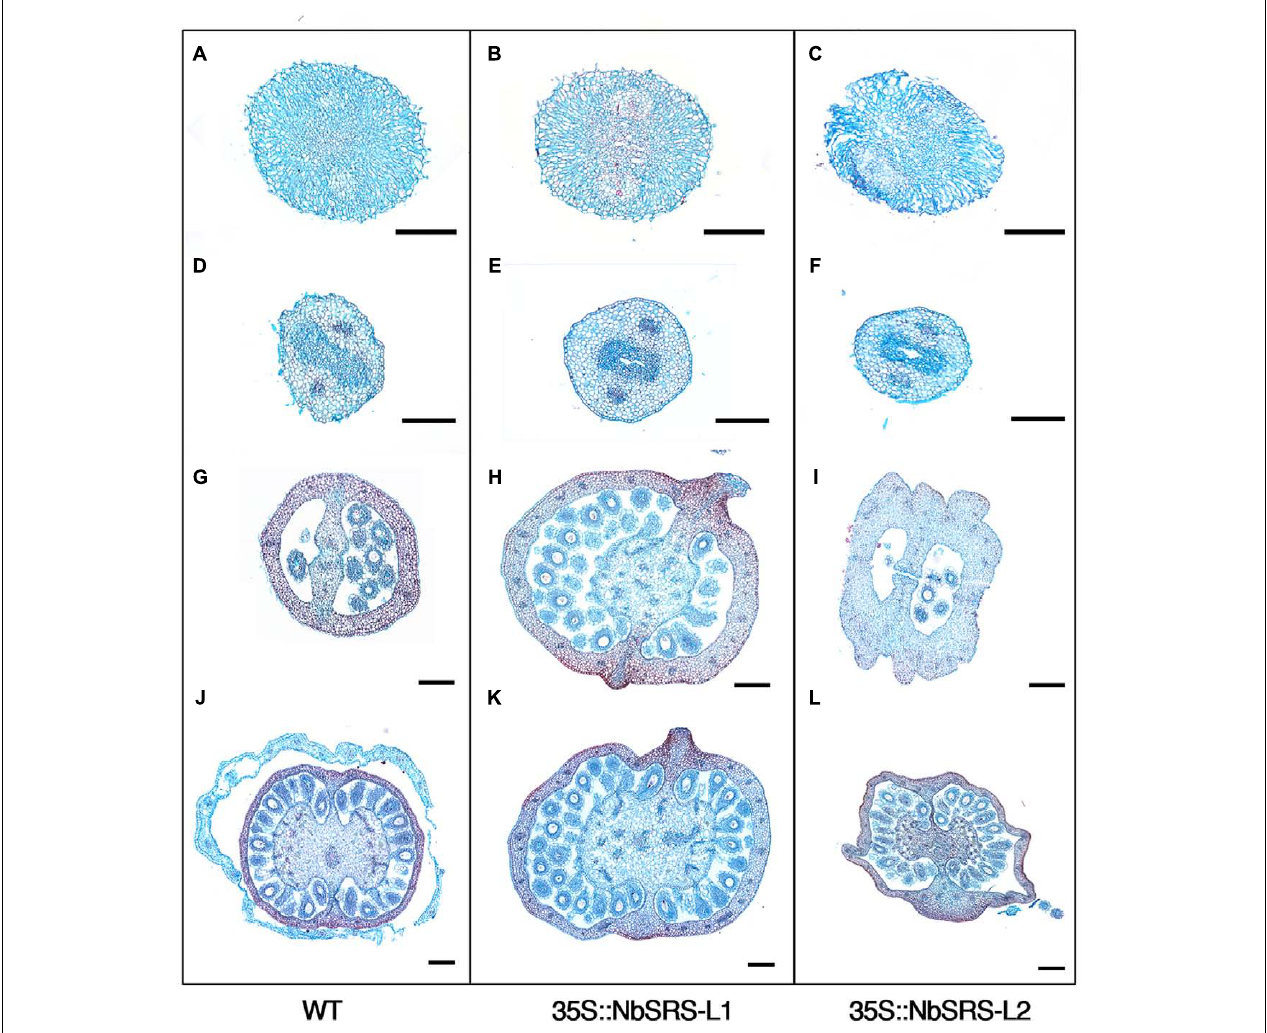
FIGURE 7 | Phenotypic characterization of N. benthamiana pistils from 35S::NbSRS-L1 and 35S::NbSRS-L2 lines. Histological sections of anthesis pistils. (A,D,G,J) Wild type. (B,E,H,K) 35S::NbSRS-L1. (C,F,I,L) 35S::NbSRS-L2. (A–C) Transversal sections of stigmas. Note the similar morphology in all cases. (D–F) Transversal sections of the style. Again, style morphology appears similar in all three genotypes. (G–I) Transversal sections at the distal portion of the ovary. Note the medial protrusions capped with stigmatic tissue in 35S::NbSRS-L1 (H) and the engrossed and irregular ovary walls in 35S::NbSRS-L2 (I) . (J–L) Transversal sections of the basal domain of the ovary. The morphology of 35S::NbSRS-L pistils is more similar to wild type, but still medial protrusions and additional cell layers in the ovary wall can be observed in 35S::NbSRS-L1 (K) and the ovary walls are irregular in shape in 35S::NbSRS-L2 (L) . Bars: 200 µ